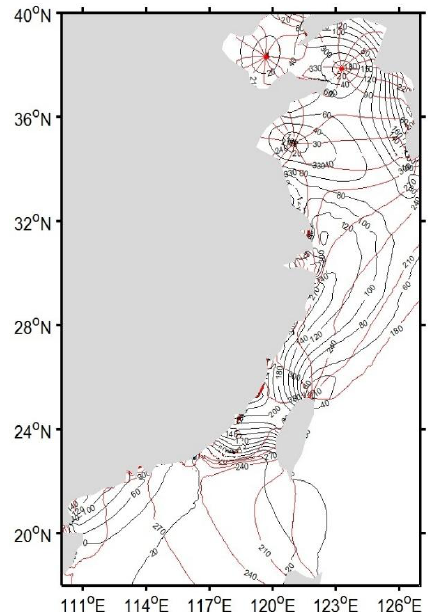
Figure 3. M2 co-tidal and co-phase charts from FVCOM. The red and black lines show the phase lag (in degrees relative to Beijing local time (UT + 8 h)) and amplitude (in centimeters), respectively. 3.2. Comparison of Model Storm Surge under NCEP Winds with Tide-Gauge Data